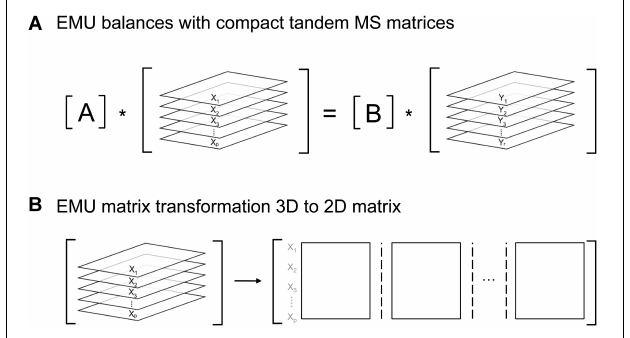
FIGURE 6 | (A) Structure of EMU equations for simulation of tandem MS data. (B) 3D-matrices X and Y can be transformed into corresponding 2D-matrices for convenience.